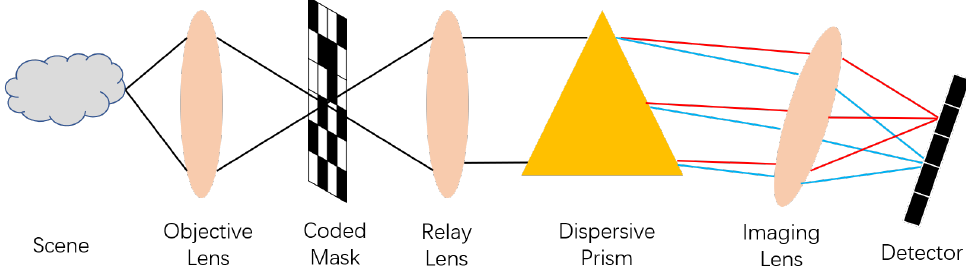
Figure 1. Sensing process of compressive spectral